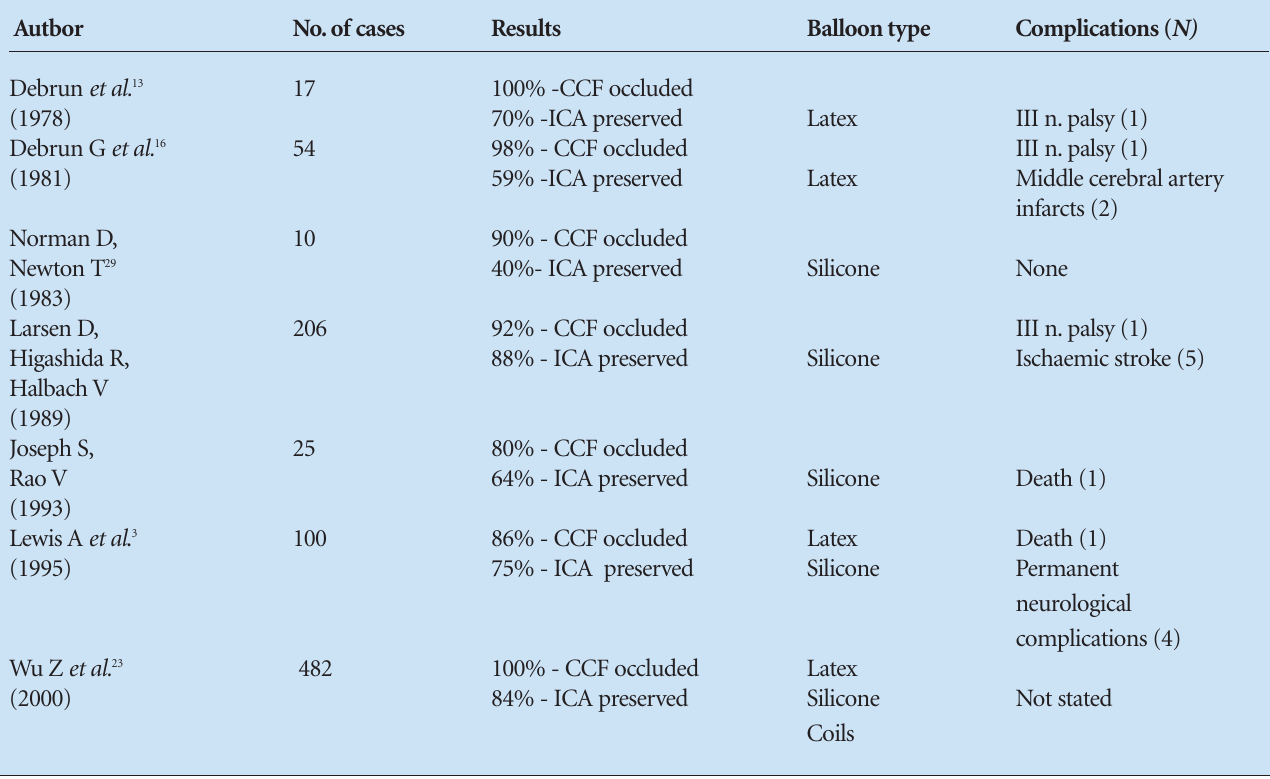
Table VI. CCF embolisation — comparative results from different centres